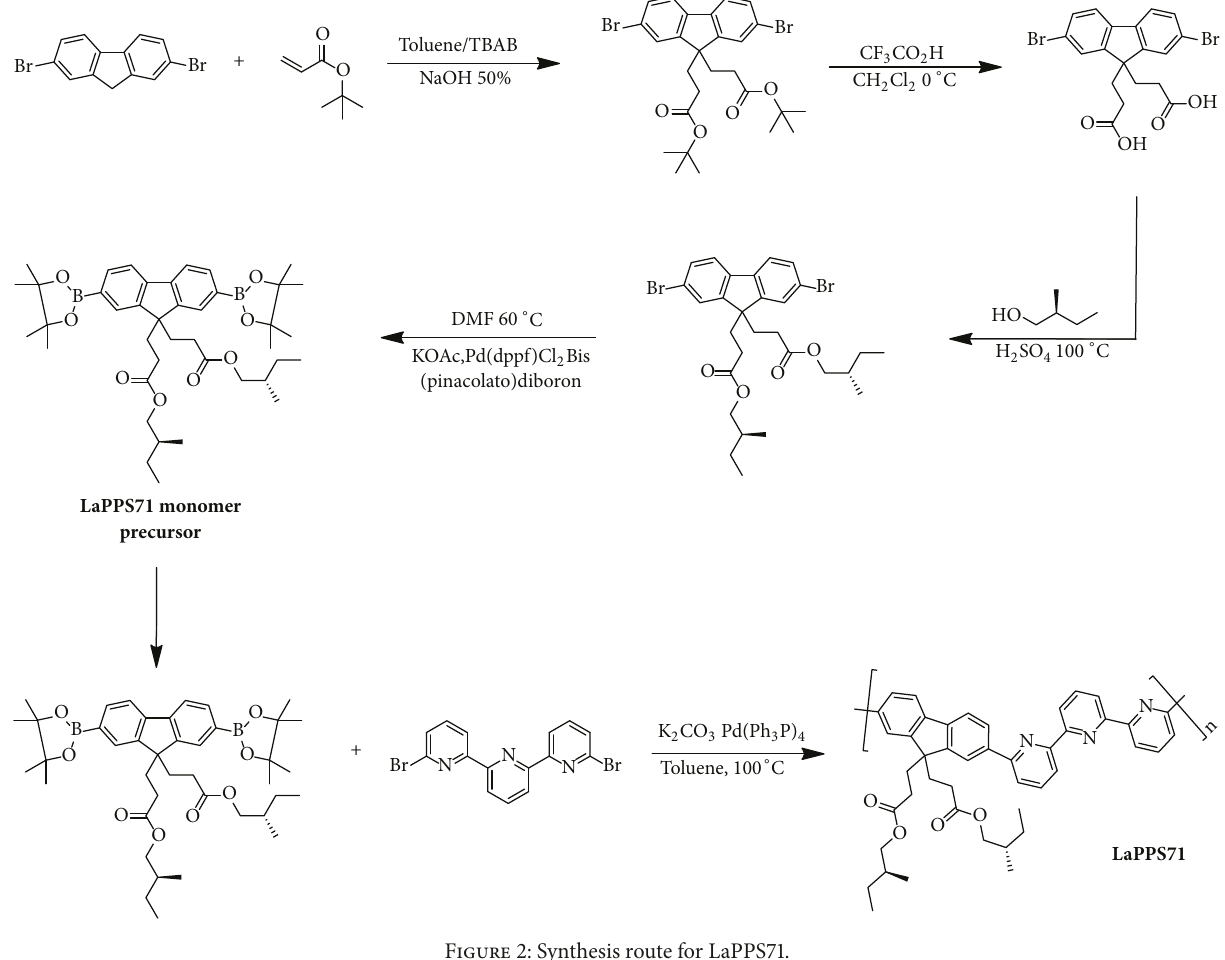
Figure 2: Synthesis route for